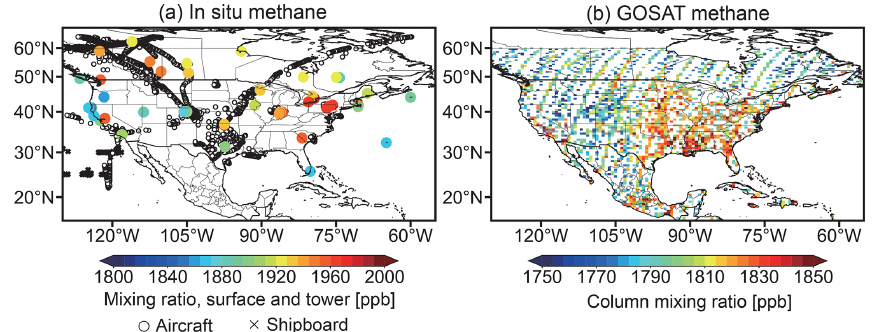
Figure 1. Methane observations over North America used in the inversion. The observations are from the in situ GLOBALVIEWplus CH 4 ObsPack data product and from the GOSAT satellite instrument. Mixing ratios shown for surface, tower, and GOSAT observations are means for 2010–2017. Aircraft and shipboard observation locations are shown as additional symbols. The GOSAT data are dry column mixing ratios from the University of Leicester version 9 Proxy XCH 4 retrieval (Parker et al., 2020a) and are averaged here on the 0 . 5 ◦ × 0 . 625 ◦ GEOS-Chem model